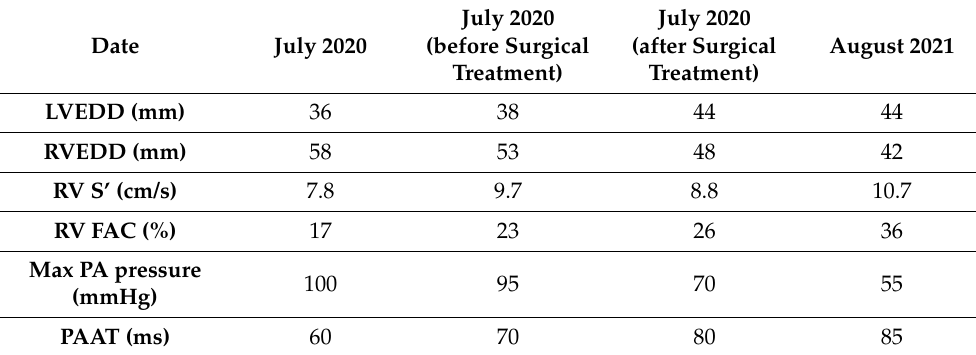
Table 2. Echocardiography results before and after surgical treatment and